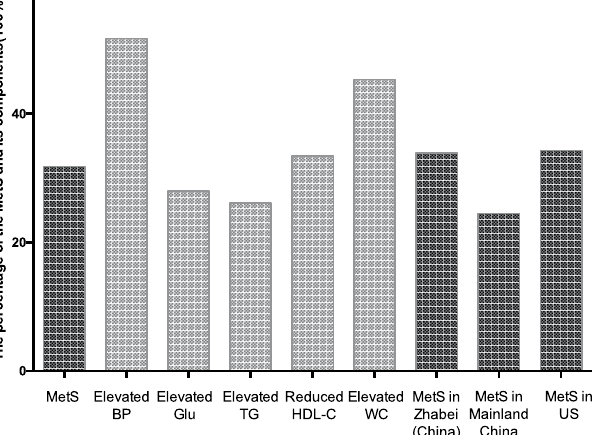
Figure 1. The prevalence of the MetS and its constituents in rural area located in Southwest China. We observed that the prevalence of MetS (31.8%) was lower than the prevalence level in Zhabei District of Shanghai in China (33.9%) reported in 2013 and that in US (34.3%) reported in 2010, but higher than that in mainland China (24.5%) reported in